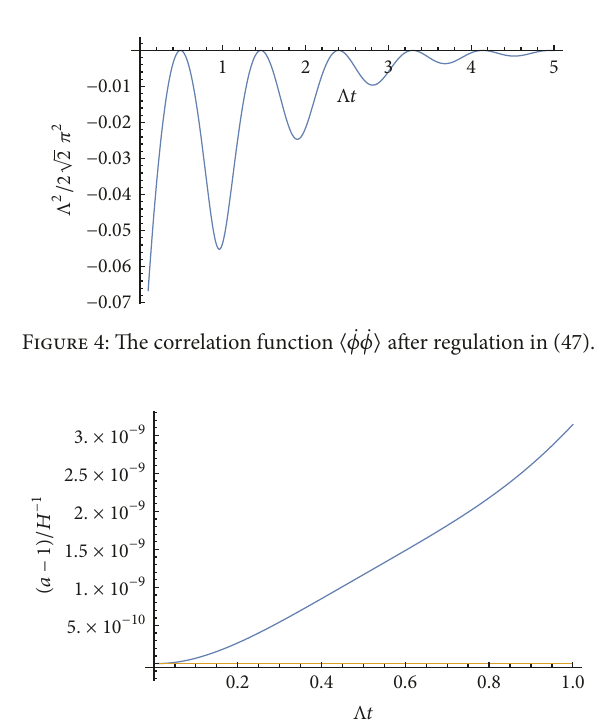
Figure 5: Scale factors at the beginning. The blue curve is for our toy model, and the orange one is for standard scenario. To illustrate the behavior of scale factors clearly, the vertical axis is rescaled as (𝑎 − 1)/𝐻 −1 , where 𝐻 = √8𝜋𝐺𝑉(0)/𝜆 .